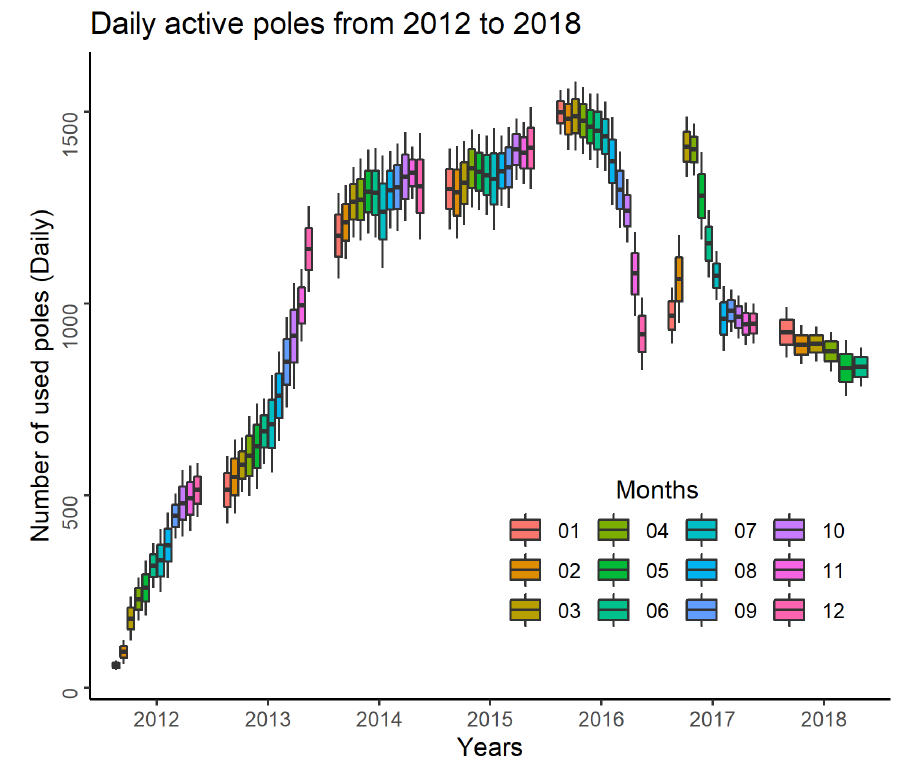
Figure 2. Number of used poles per day, from 2012 to 2018. Each boxplot represents data for 1 month. The y -axis represents the number of daily active